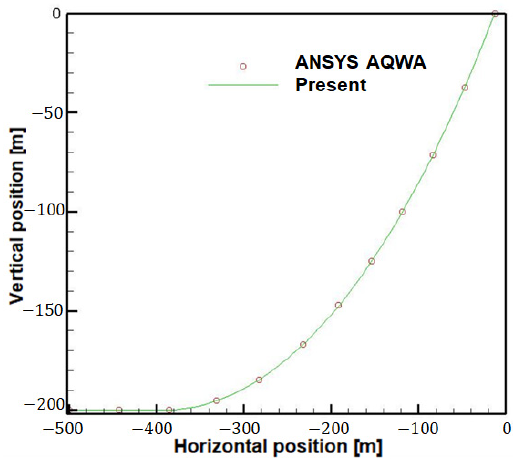
Figure 5. Static profile of mooring line.